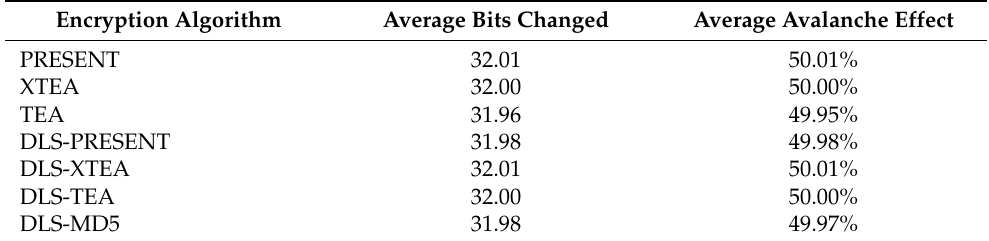
Table 3. A summary of average number of bits changed and avalanche effect measured over 50,000 random plaintexts.